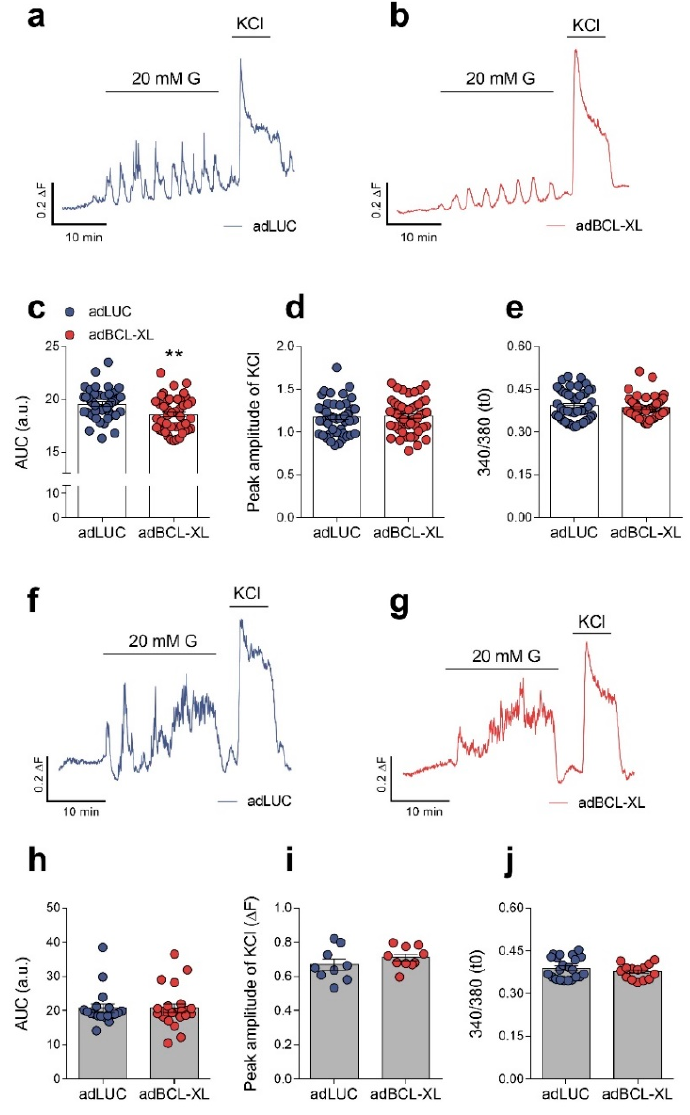
Figure 2. BCL-XL overexpression reduces intracellular Ca 2+ oscillations in rat but not in human β -cells. INS-1E ( a – e , white bars) and EndoC- β H1 cells ( f – j , grey bars) were infected with adenoviral (ad) vectors encoding luciferase (adLUC, blue traces or dots) or rat BCL-XL (adBCL-XL, red traces or dots). After 48 h of recovery, intracellular Ca 2+ dynamics was assessed using Fura-2AM fluorescence. Representative recordings of Fura-2AM Ca 2+ fluorescence in INS-1E ( a , b ) and EndoC- β H1 cells ( f , g ). ( c , h ) Quantification of area under curve (AUC) in intracellular Ca 2+ changes in response to 20 mM glucose (20 mM G) in INS-1E ( c ) and EndoC- β H1 cells ( h ). ( d , i ) Amplitude of the intracellular Ca 2+ peak responses elicited by 20 mM KCl were measured in INS-1E ( d ) and EndoC- β H1 cells ( i ). ( e , j ) F340/F380 ratio under non-stimulatory glucose concentrations in INS-1E ( e ) and EndoC- β H1 cells ( j ). Results are the means ± SEM of 44–53 individual cell registers, where each dot represents a register (4–6 independent experiments per cell line). ** p ≤ 0.01 vs. adLUC. Two-tailed Student’s t -test.